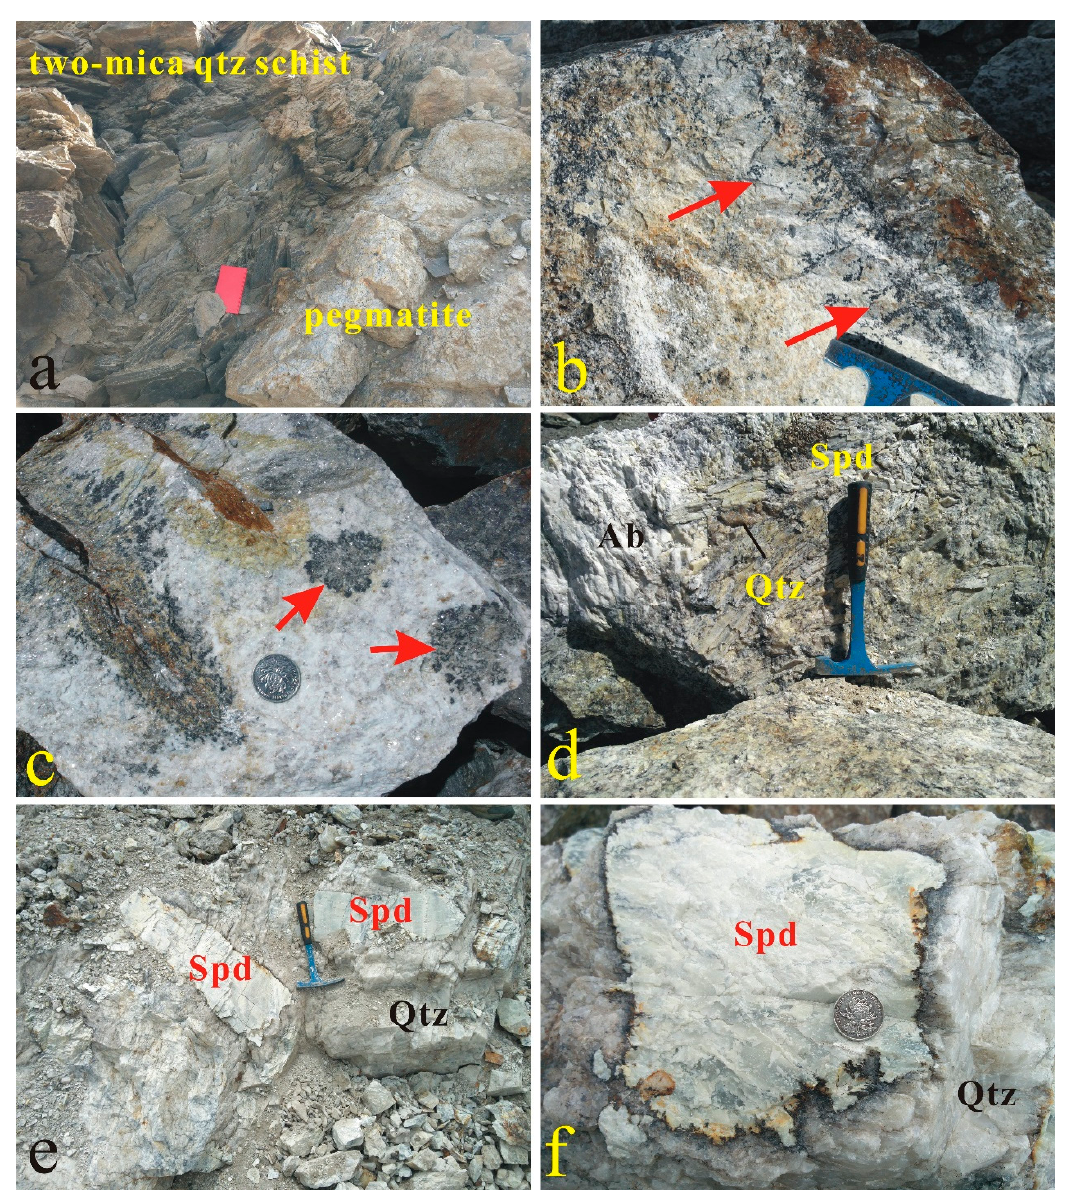
Figure 3. Field photos showing typical textures of No. 90 pegmatite. ( a ) the contact between the country rock (two-mica quartz schists) and the pegmatite. ( b ) oriented dendritic aggregates of dark minerals growing inwards from the contact zone between the Wall Zone of No. 90 pegmatite and country rock. ( c ) aggregate of dark minerals in the albitized Wall Zone. ( d ) typical mineralogy of the spodumene-muscovite-quartz zone. ( e ) megacrystic spodumene-quartz zone. ( f ) megacrystic spodumene showing a dark rim dominated by spodumene-quartz intergrowths (see Figure 4e,f). The length of the notebook, hammer and marker are 15 cm, 45 cm, and 10 cm, respectively. The diameter of the coin is 2 cm. Mineral abbreviations: Ab = albite, Qtz = quartz, and Spd = spodumene.